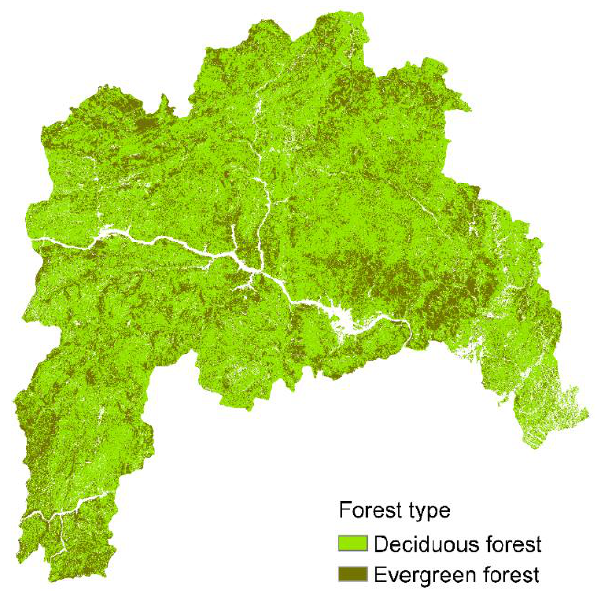
Figure 9. Classification result of forest types.